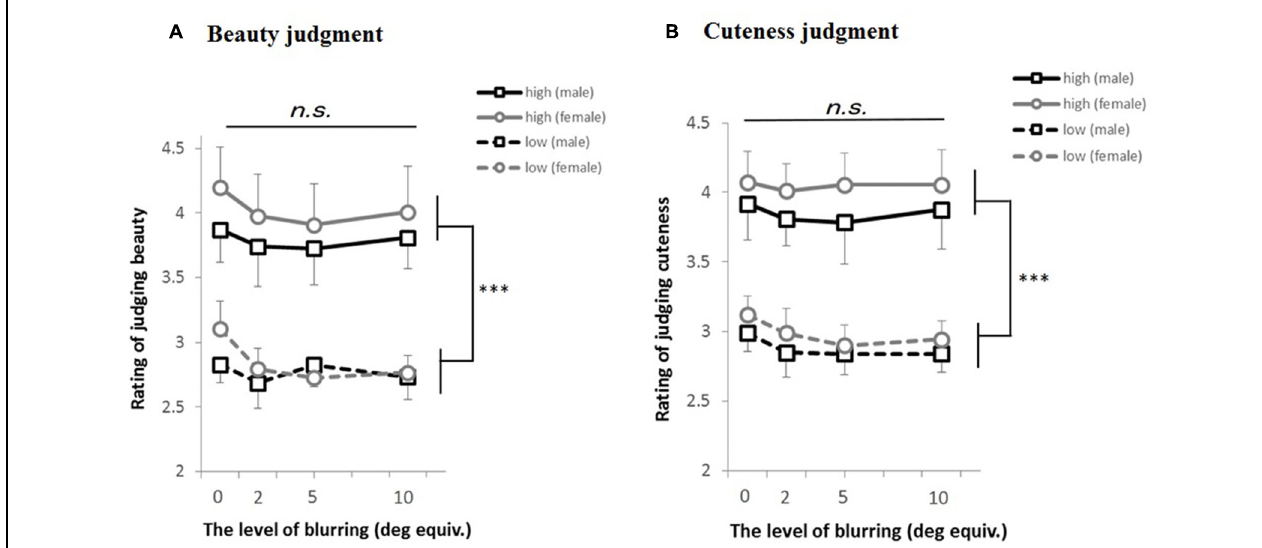
FIGURE 6 | The results of rating beauty (A) and cuteness (B) in Experiment 2. The black lines represent the male participants, and the gray lines represent the female participants. The solid lines show the data of the high group used in Experiment 1, and the broken lines show the data of the low group. The error bars show the SEM across participants. ∗∗∗ p <